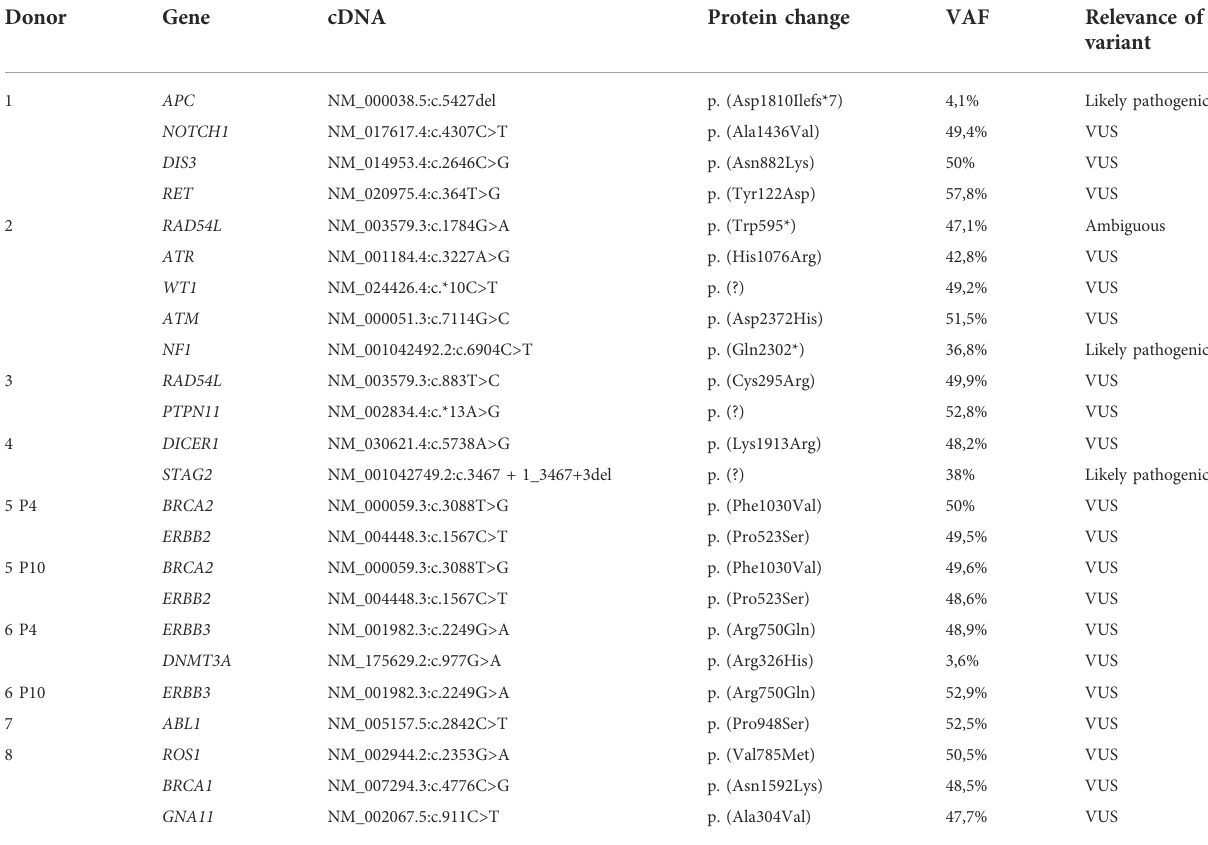
TABLE 5 Overview of the genetic variants detected using a gene panel consisting of 165 tumor-associated genes. MSCs from donor 5 and 6 were harvested at passage 4 (P4) and 10 (P10) for sequencing, for all other donors cells were harvested at passage 4. VAF = variant allele frequency, VUS = variant of unknown signi fi